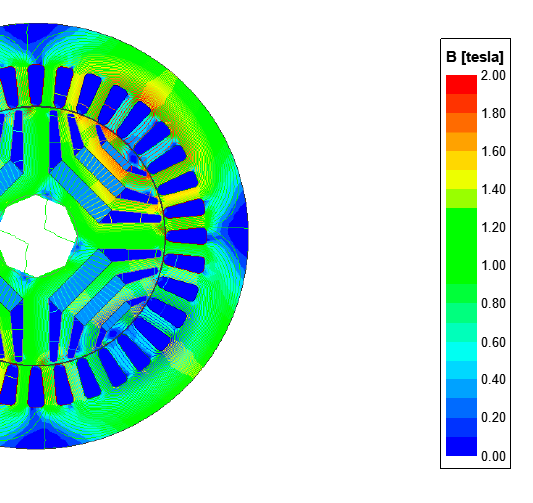
Figure 4. FMSynRM efficiency map for speeds and winding currents up to the rated values.